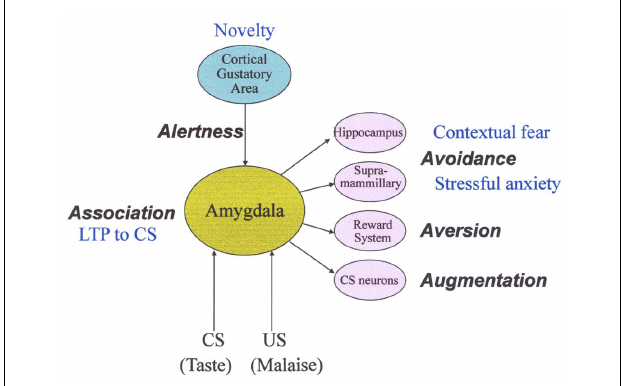
FIGURE 3 | Behavioral and neural characteristics of conditioned taste aversion. CS, conditioned stimulus; US, unconditioned stimulus; LTP, long-term potentiation. See text for